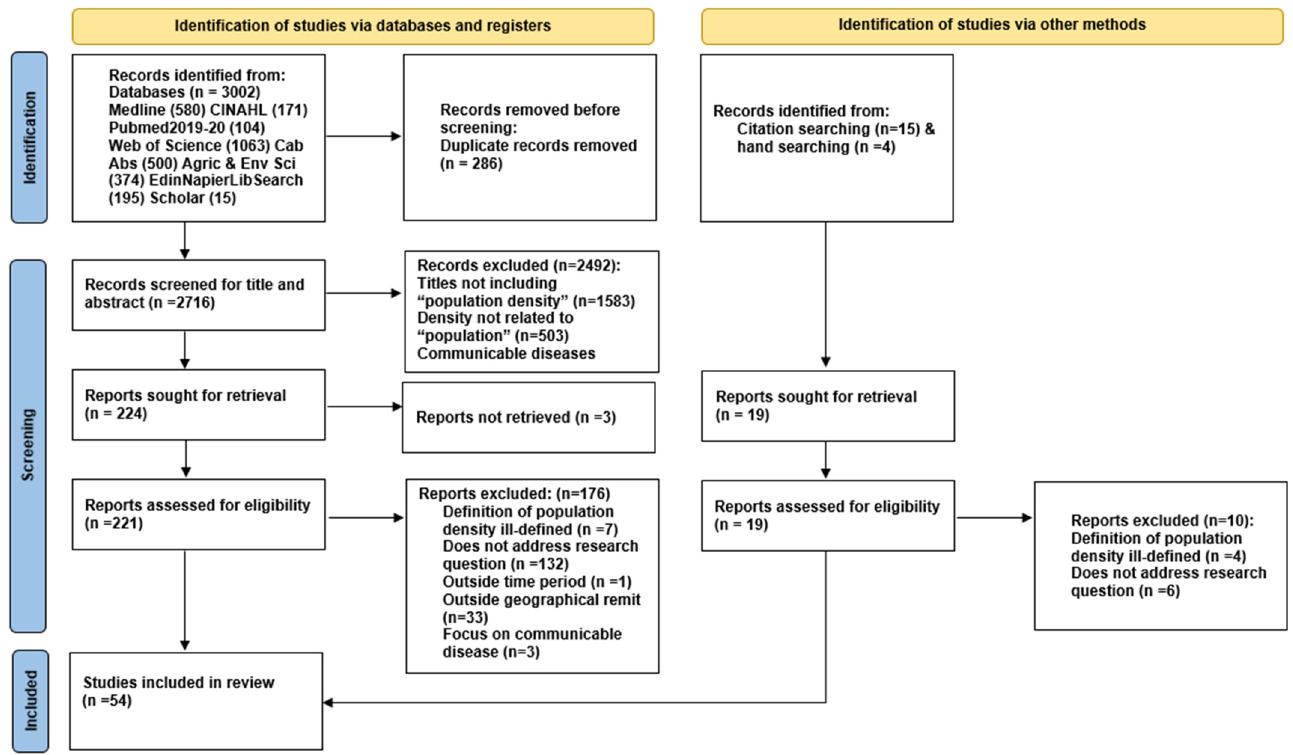
Figure 1. PRISMA 2020 flow diagram for new systematic reviews.